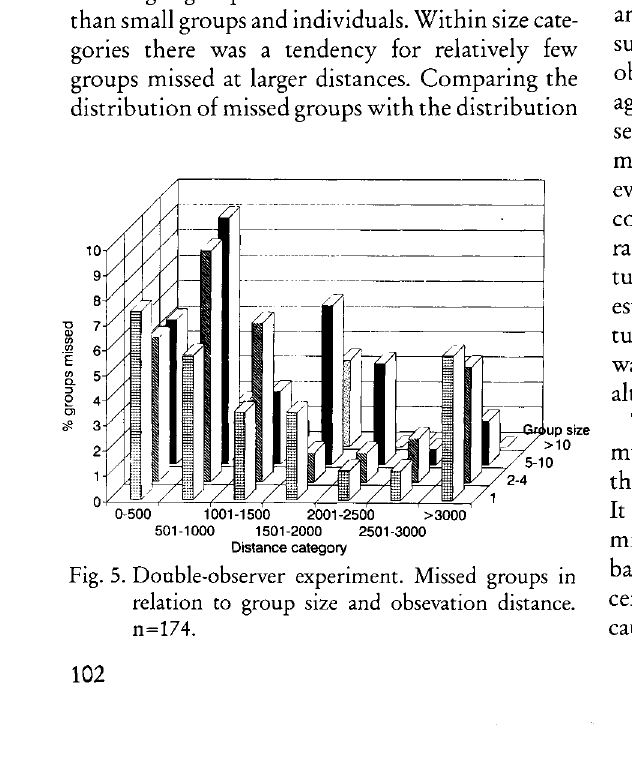
Fig. 5. Double-observer experiment. Missed groups in relation to group size and obsevation distance. n=174.